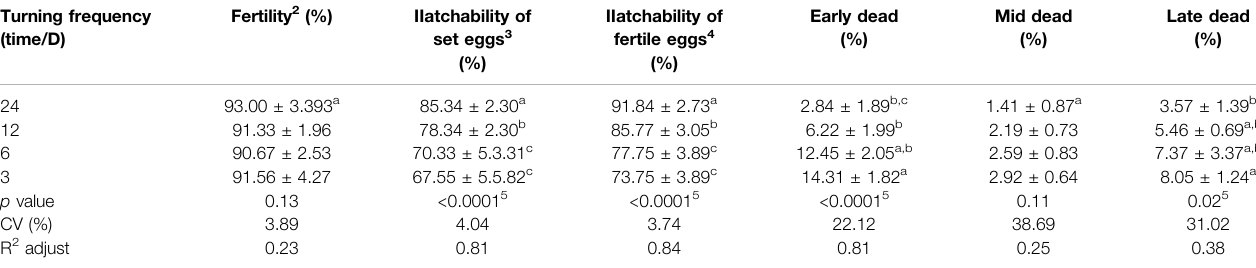
TABLE 2 | Fertility, hatchability of fertile eggs, and embryonic mortality according to the turning frequency (Oliveira et al., 2020). Turning frequency (time/D)